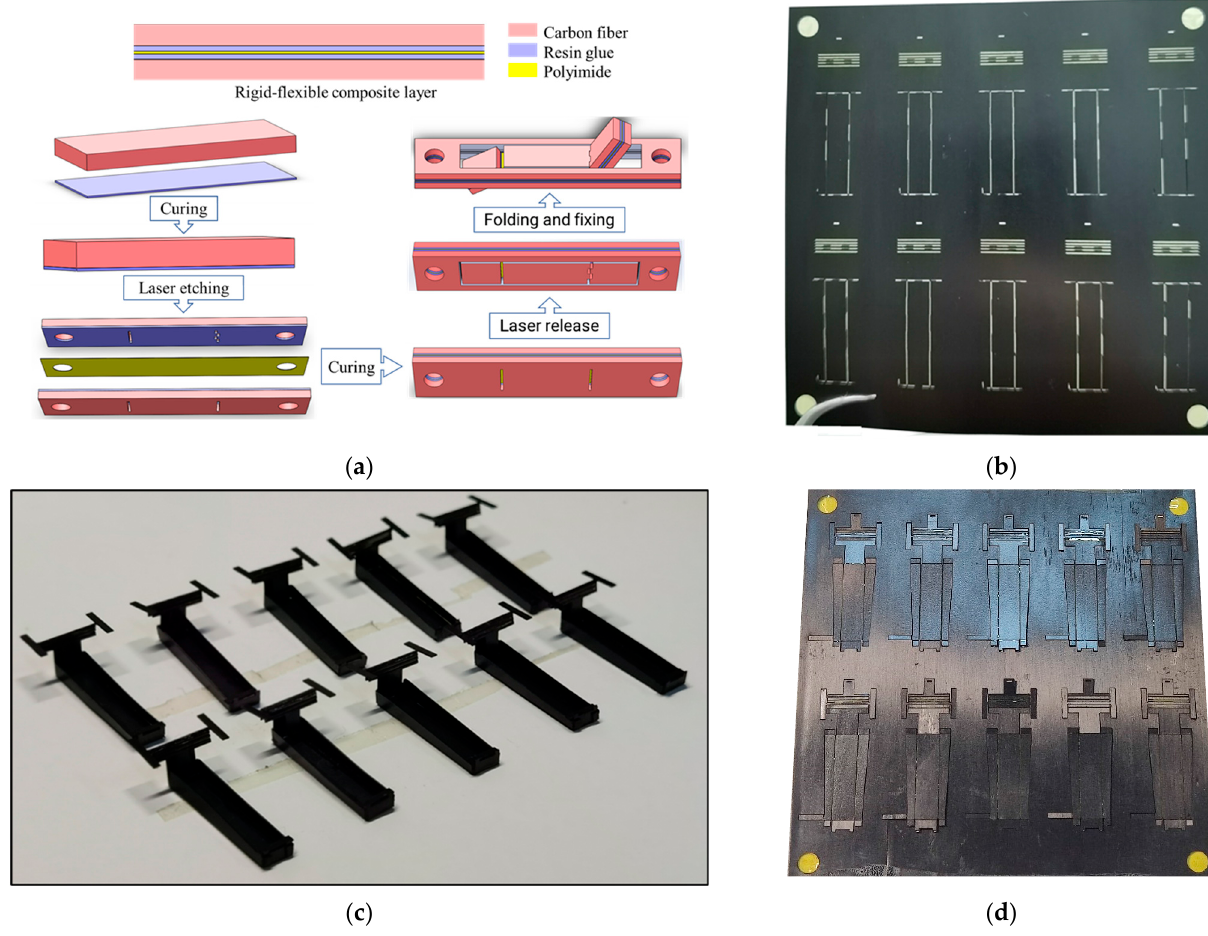
Figure 3. Manufacturing of deformation mechanics: ( a ) processing flow of deformation mechanics; ( b ) array processing of deformation mechanics’s hinge holes; ( c ) batch release of deformation mechanics; ( d ) deformation mechanics processed at one time.